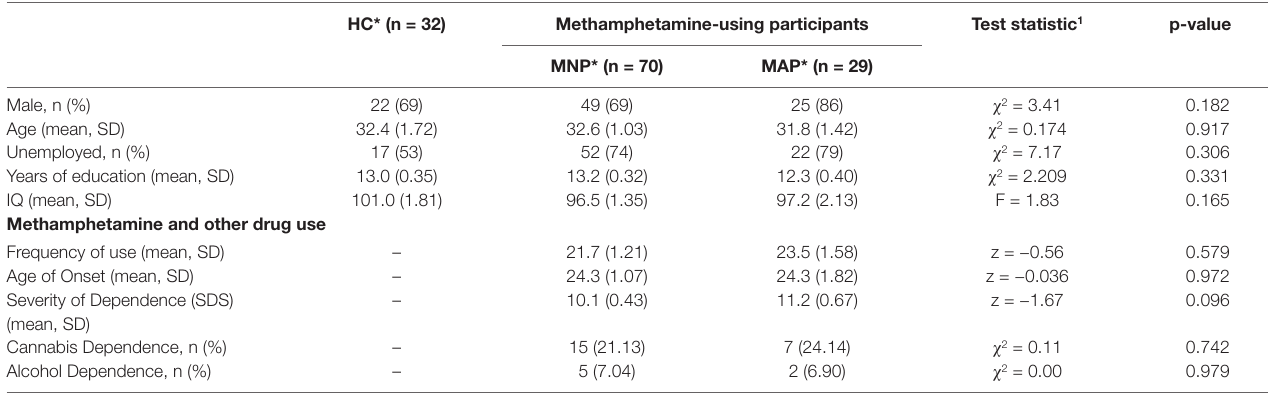
TaBlE 1 | Participant characteristics.